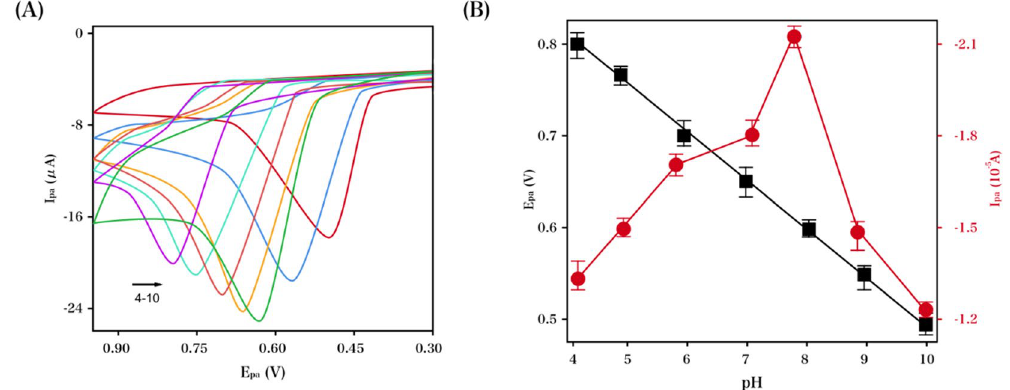
Figure 5. ( A ) CV profiles of 0.1 mM NGF at RGO–TiN/GCE in PB (0.1 M) with varying pH values. ( B ) Influence of the pH on the peak current and potential at a scan rate of 50 mV/s.